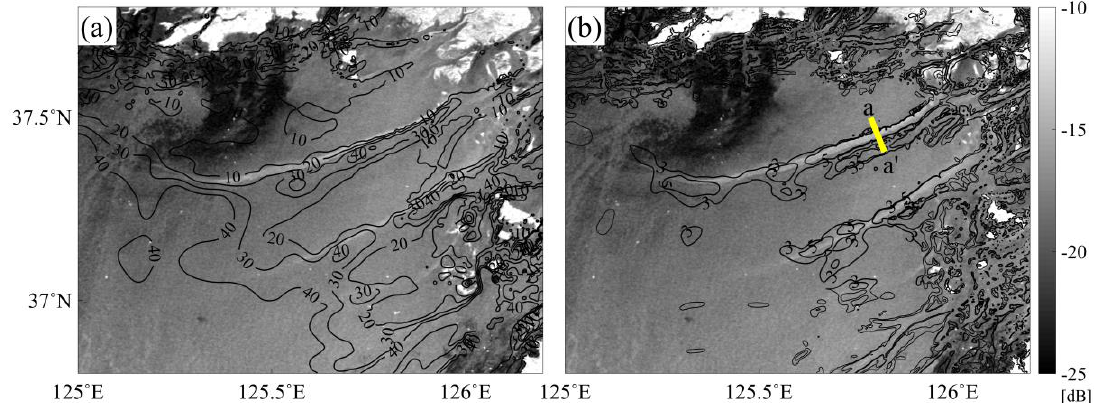
Figure 3. The distribution of normalized radar cross sections (NRCSs) from the SAR image acquired on 11 December 2007, with contours of ( a ) water depth (m) and ( b ) its gradient, where the yellow line (a-a’) represents the section crossing the maximum depth gradient line.